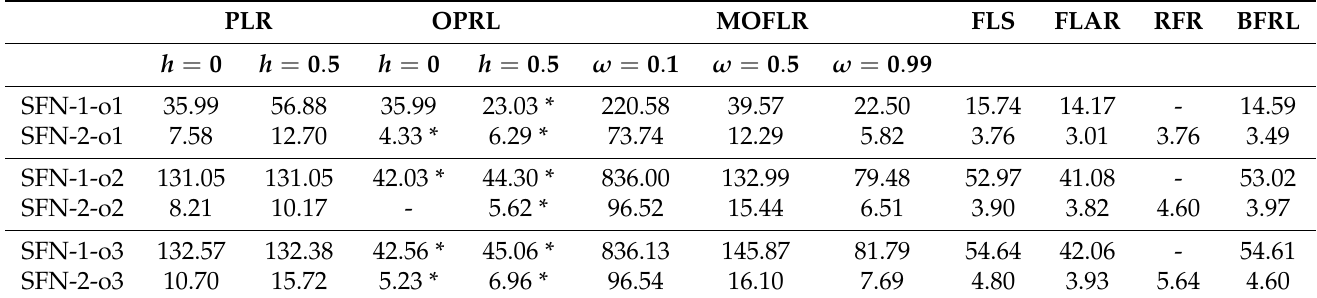
Table 3. Total errors of the possibilistic linear regression (PLR), the PLR combined with the omission approach (OPRL), the multi-objective fuzzy linear regression (MOFLR), the fuzzy least squares (FLS), the fuzzy least absolute linear regression (FLAR), the robust fuzzy regression (RFR) analysis, and the Boscovich fuzzy regression line (BFRL). Method tested on datasets with symmetric fuzzy numbers SFN-1 and SFN-2 affected by outliers of type o1, o2 and o3 (first column). Settings of adjustable parameters h and ω are stated under method abbreviations. Asterisk indicates correctly recognized outliers by OPRL.